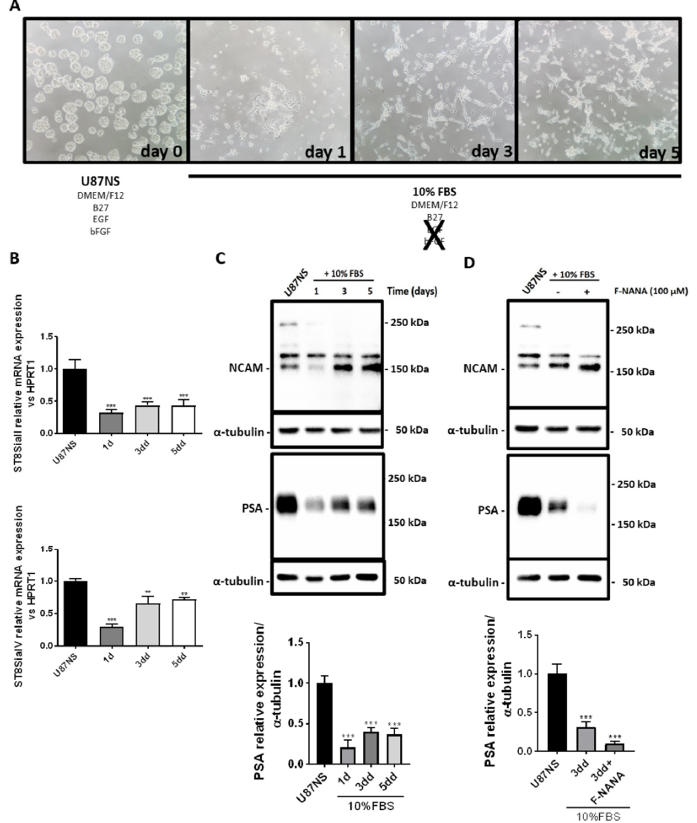
Figure 6. PolySTs, NCAM and PSA expression during U87NS cell differentiation. ( A ) Phase-contrast micrographs showing floating U87NS differentiated in medium supplemented with 10% FBS for 5 days. Images were acquired at day 0, 1, 3 and 5. ( B ) Real-time PCR analysis of ST8SiaII and IV mRNAs expression in U87NS differentiated for 5 days in medium supplemented with 10% FBS. ( C ) Western blot analysis showing the levels of NCAM and PSA in U87NS differentiated for 5 days in medium supplemented with 10% FBS. ( D ) Western blot analysis of NCAM and PSA expression in U87NS differentiated for 3 days in medium supplemented with 10% FBS, in presence or not of 100 μ M F-NANA. Results are presented as the mean ± SD of three independent experiments. 1d: day 1;